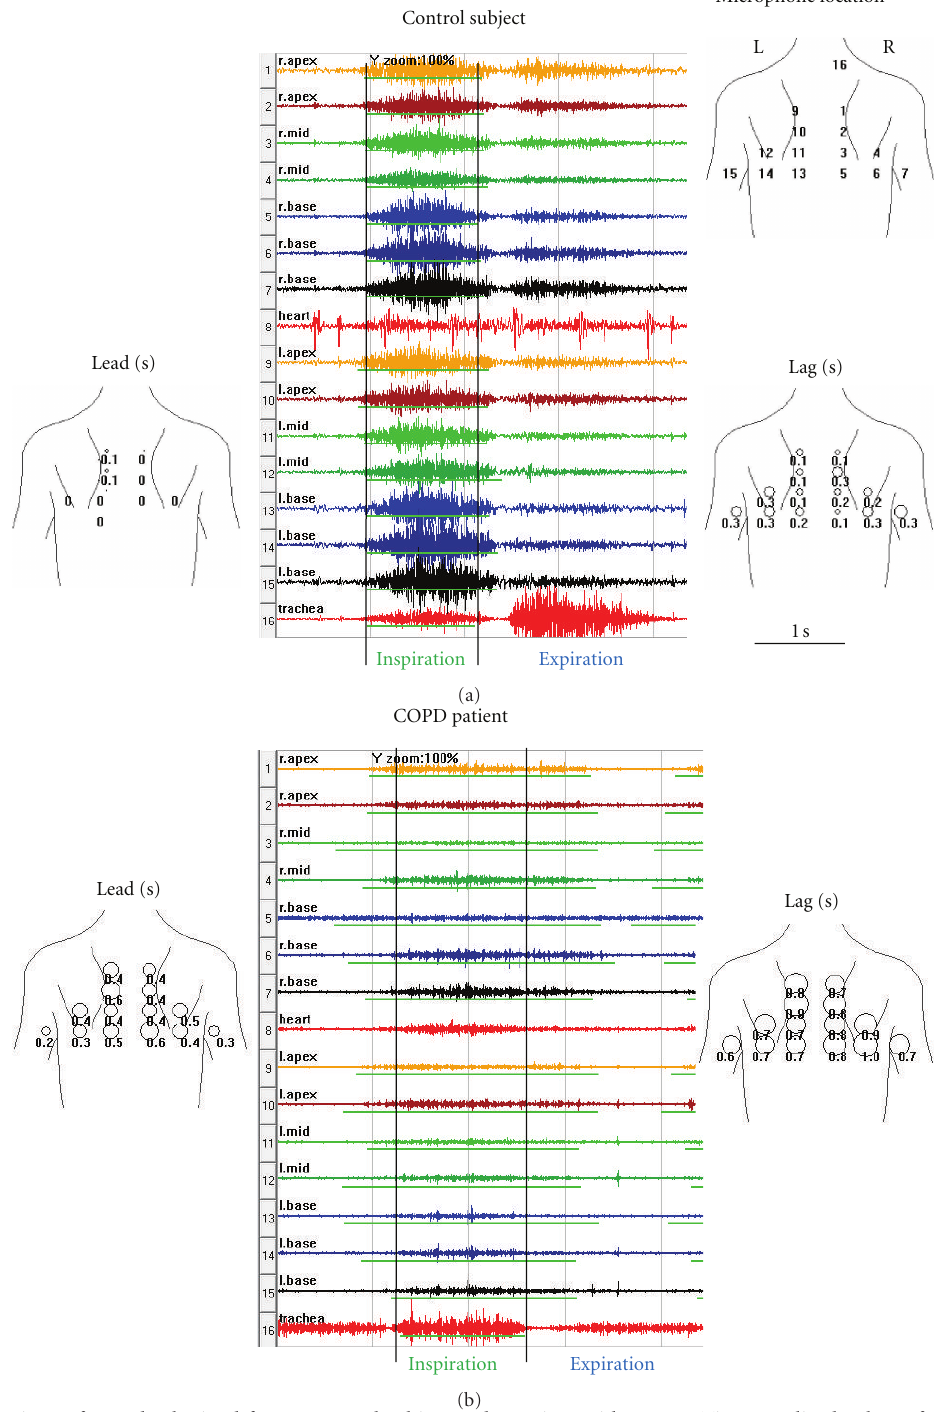
(b) Figure 4: Comparison of sounds obtained from a control subject and a patient with COPD. Time amplitude plots of a single breath are displayed in stacked mode, center panel. The choice of colors is arbitrary and used here to aid in visual separation of channels. The thin green line under each channel waveform indicates the duration of inspiration at that channel as automatically identified by the STG software. Vertical lines mark the start and the end of inspiratory sound recorded at the trachea. Notice that in the control subject the inspiratory sound starts and ends at almost the same time at all the chest sites as well as the trachea. In COPD, inspiratory lung sounds at the chest sites lead the inspiratory sound at the trachea in the beginning of the inspiration. In addition, inspiratory lung sounds at the chest sites tend to lag the inspiratory sound at the trachea at the end of inspiration. The lead time at each chest wall site is displayed superimposed over the body plot, left panel. The circle diameter is proportional to the time delay. The lag time at each chest wall site is also displayed, right panel. The top right panel shows microphone location on the chest. In the control patient, the average lead was 15ms or 1% and the average lag 199ms or 17%. In the COPD patient, the average lead was 267 ms or 22% and the average lag 520 ms or 43%. In the control patient, the lead asynchrony was 2% and lag asynchrony was 18%. In the COPD patient, the lead asynchrony was 24% and lag asynchrony was